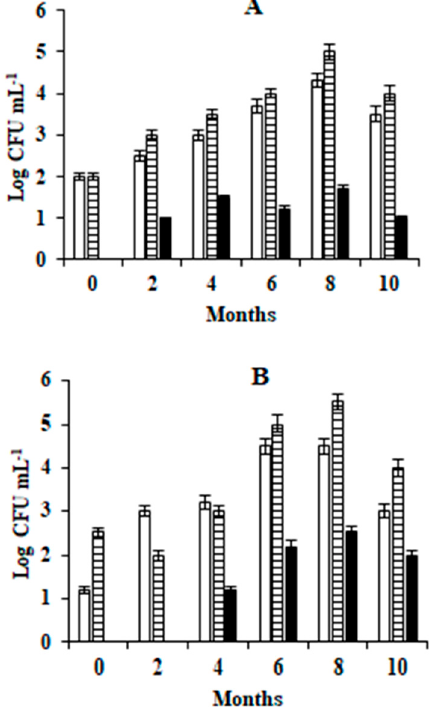
Figure 3. Microbiological analysis of Leccino (A) and Taggiasca (B) black table olive brines during the fermentation in industrial-scale plastic barrels. ( (cid:0) , Total aerobic bacteria; , yeast; ■ , mold). Table 1. Yeast film production in vitro by the predominant species isolated from brines after 10 months of fermentation in industrial